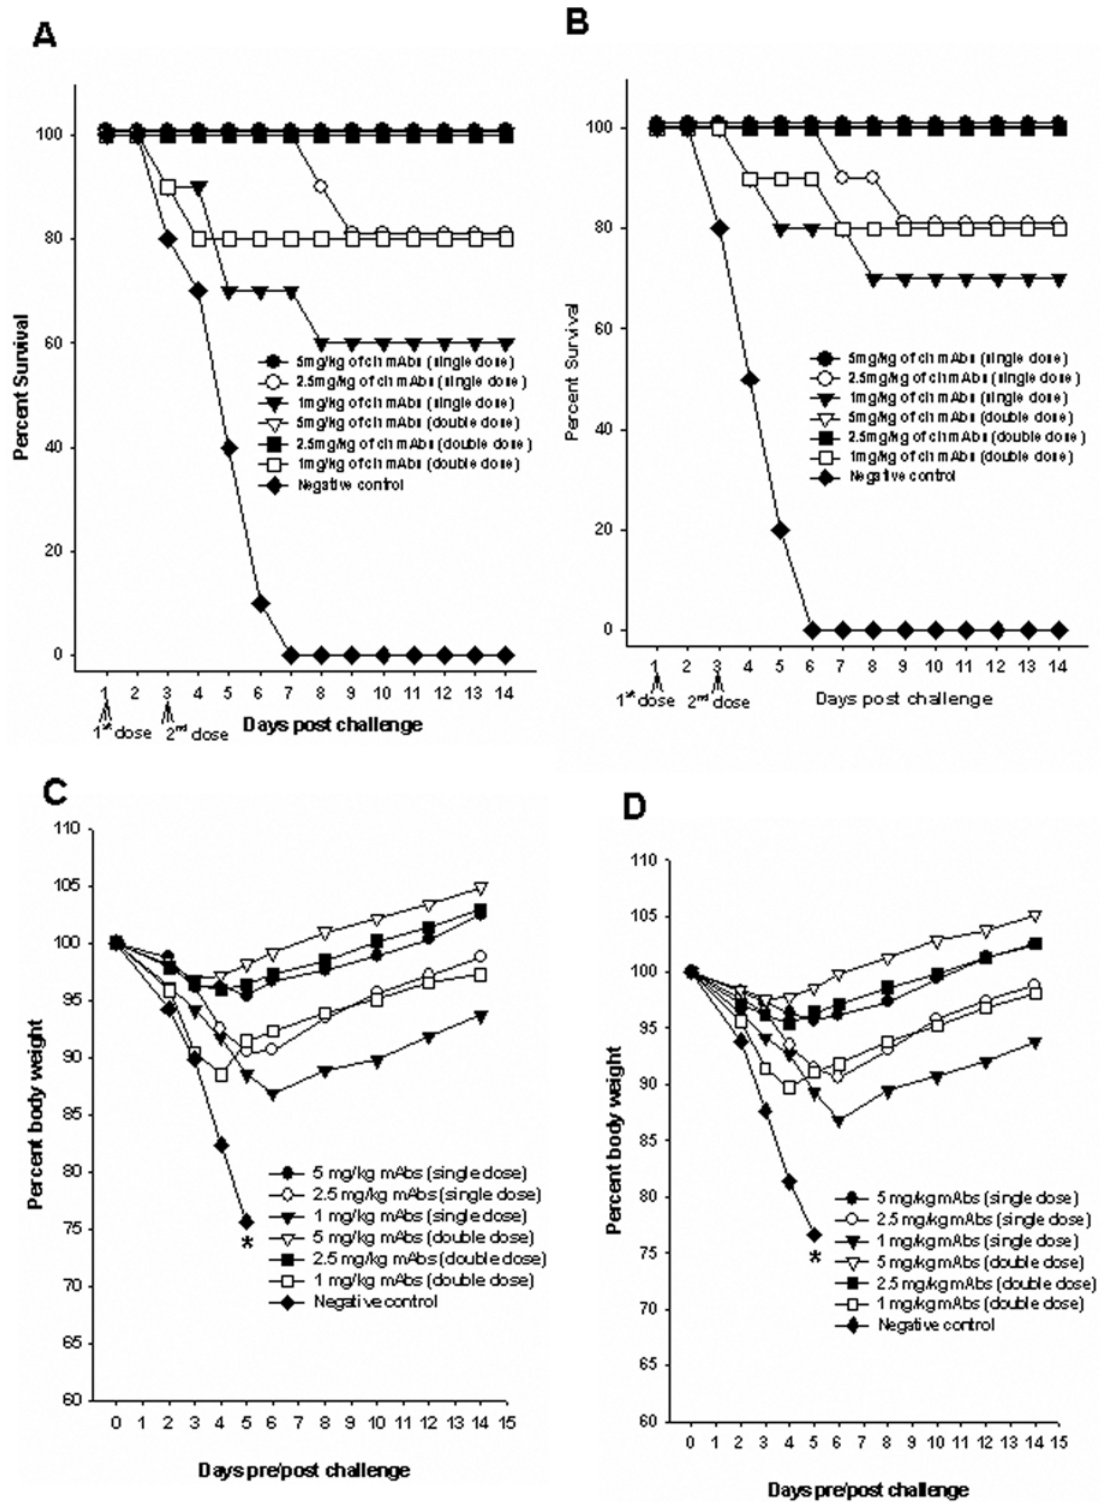
Figure 3. Therapeutic potential of one versus two doses of the combination of chimeric mAbs in mice. Groups of mice (n=10) were infected with mouse-adapted HPAI H5N1 from Clade 1 A/Vietnam/1203/2004 (A and C) and clade 2.1 virus A/TLL013/06 (B and D). For treatment with a single dose, 24 h after viral challenge, the mice were treated via intra-peritoneal route with 1.0 mg/kg, 2.5 mg/kg, 5 mg/kg or 0 mg/kg (PBS) of the combination of mAbs. For treatment with two doses, different sets of mice were treated twice with similar doses of chimeric mAbs 24 h and 72 h after the viral challenge. An irrelevant IgG1 monoclonal antibody (specific for porcine circovirus) was used as a negative control. Mice were monitored for survival (A and B) and weight loss (C and D) throughout a 14 day observation period. The results are expressed in terms of percent survival and percent body weight (at the beginning of the trial) respectively. doi:10.1371/journal.pone.0005672.g003 PLoS ONE |